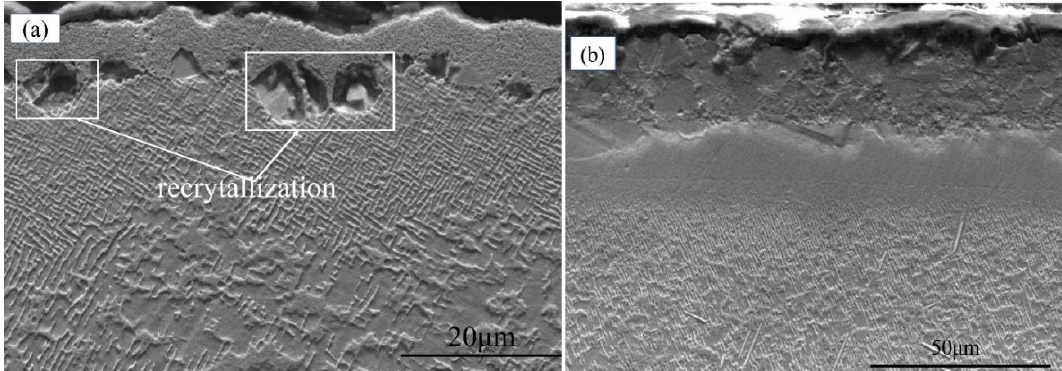
Figure 3. Specimen recrystallization morphology at 0.2 MPa sandblasting pressure in ( a ) uncoated and ( b ) coated alloys.